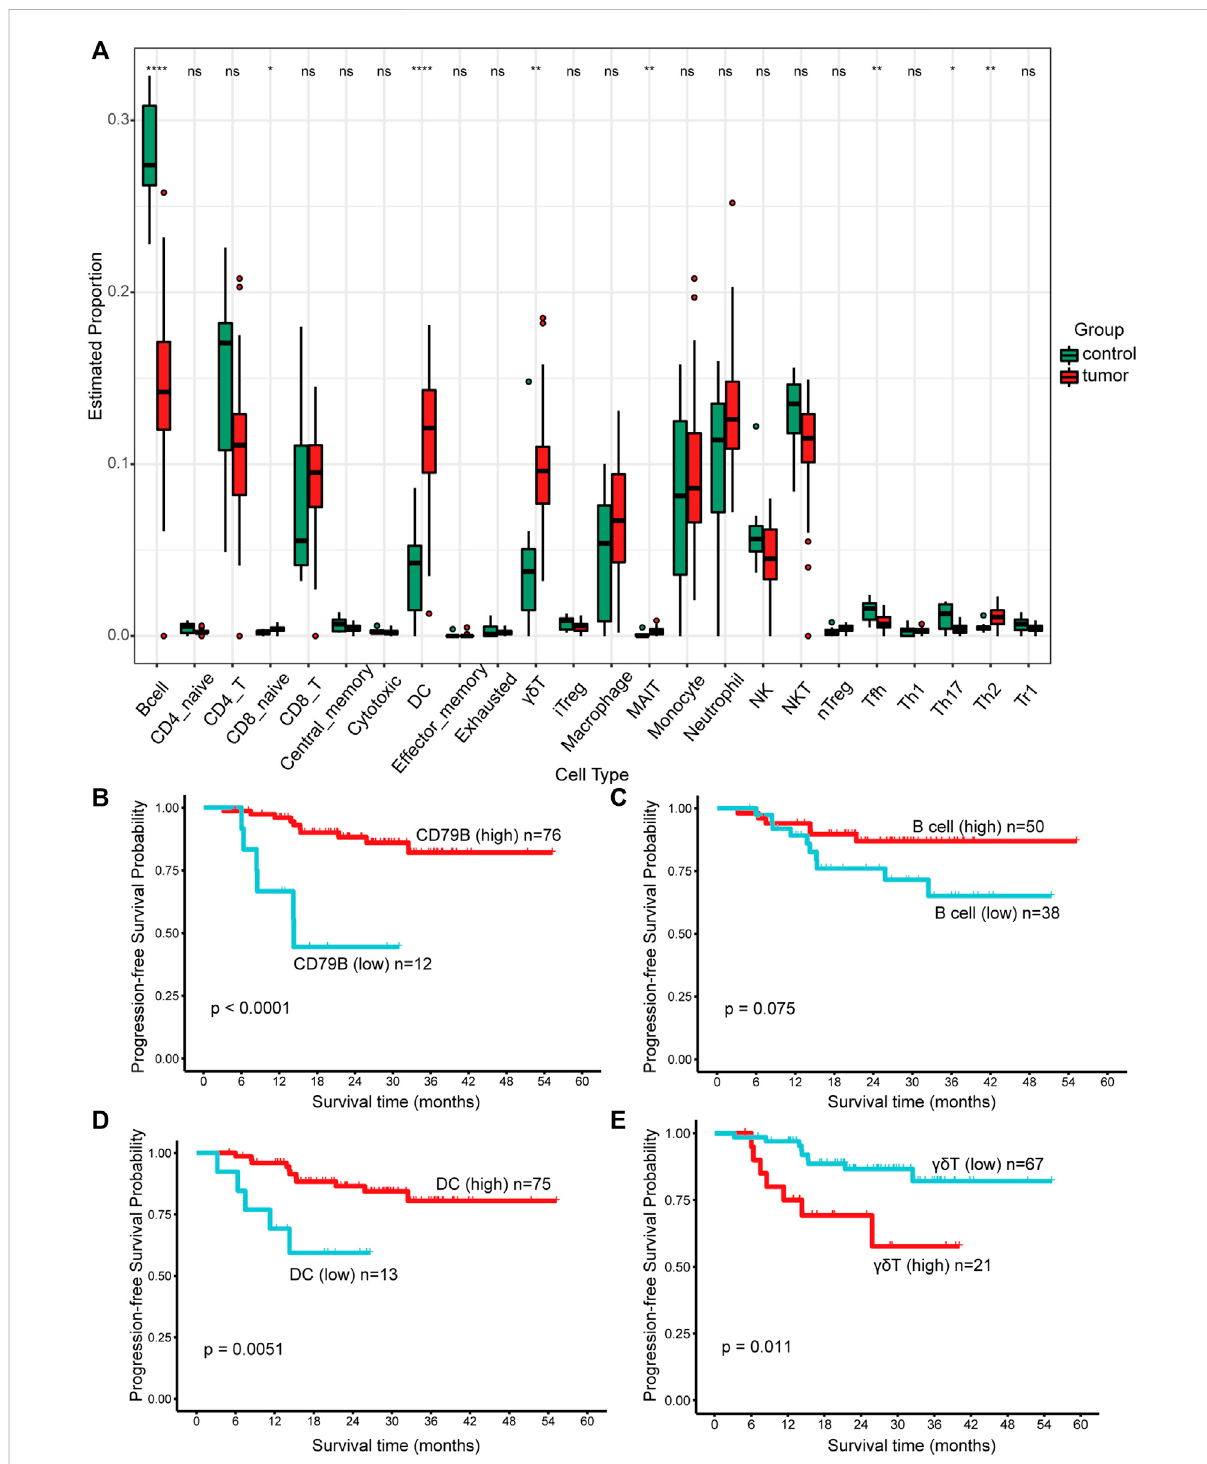
FIGURE 6 Theproportions ofimmune cellsand theirprognostic signi fi cance analysis. (A) Theproportionsofimmunecells in fi ltrated incontrol andtumor tissues. Data were analyzed using the Kruskal ‒ Wallistest. A p value > 0.05 was considered not statistically signi fi cant and represented as ns, while a p value ≤ 0.05 was represented as *, ≤ 0.01 as **, ≤ 0.001 as ***, and ≤ 0.0001 as ****. (B – E) Kaplan – Meier survival analysis of progression-free survival (PFS). The best cut-off values which were determined by the R package Survminer were selected to divide the cases into high and low expression groups. A p value < 0.1 was considered statistically signi fi